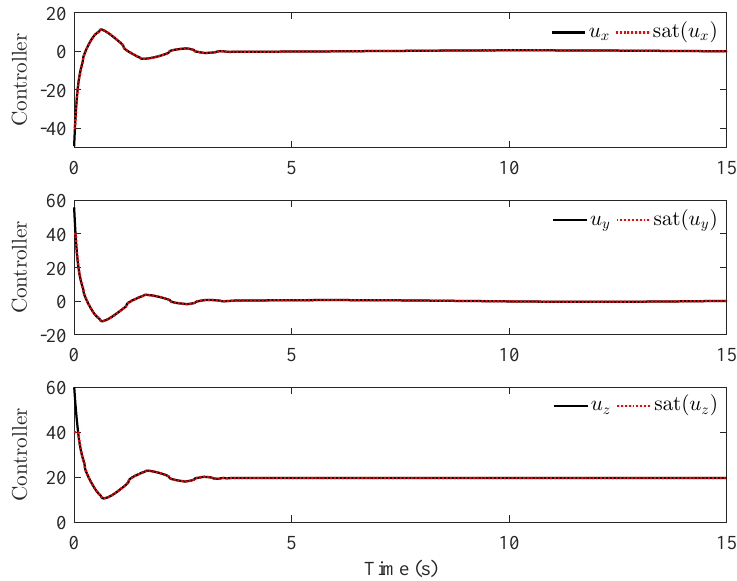
Figure 6. The control inputs of the position